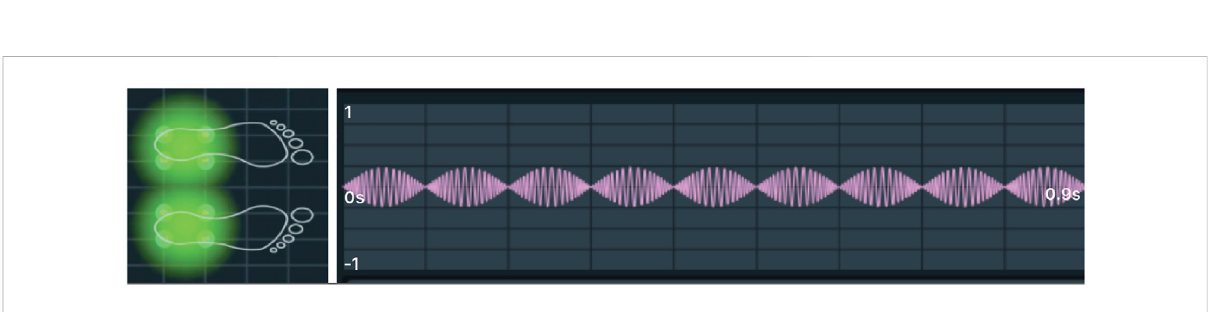
FIGURE 6 Vibrotactile jumping sensations: A 5 Hz sine wave was superimposed with a 200 Hz sine wave that has a 10 Hz FM (from Syntacts).